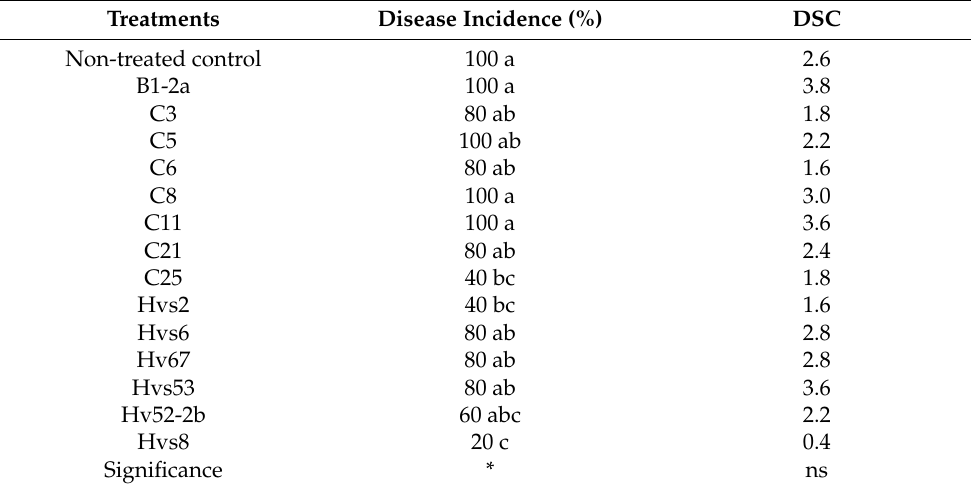
Table 2. Biocontrol effect of selected bacterial strains against Macrophomina phaseolina TOR-102 isolate on strawberry plants (cv. ‘Candonga’) assessed as disease incidence expressed as percentage of dead plants, and disease severity in the crowns (DSC).